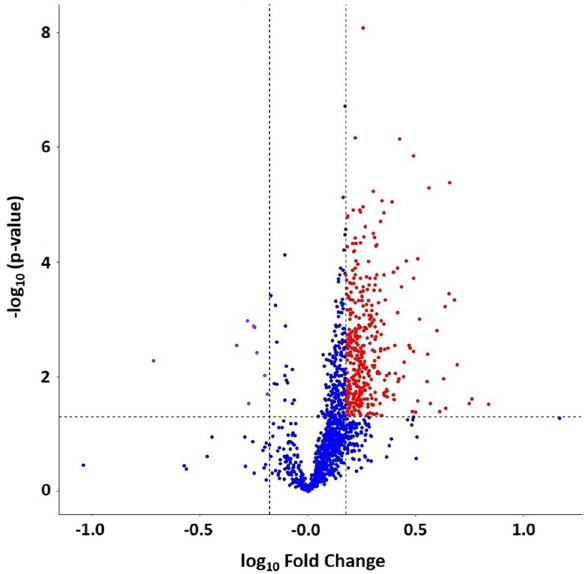
Figure 1. Volcano plot showing change in protein expression, mastocytosis patients vs control: proteins with a p value < 0.05 were considered significant when compared to controls (dotted horizontal line). Fold